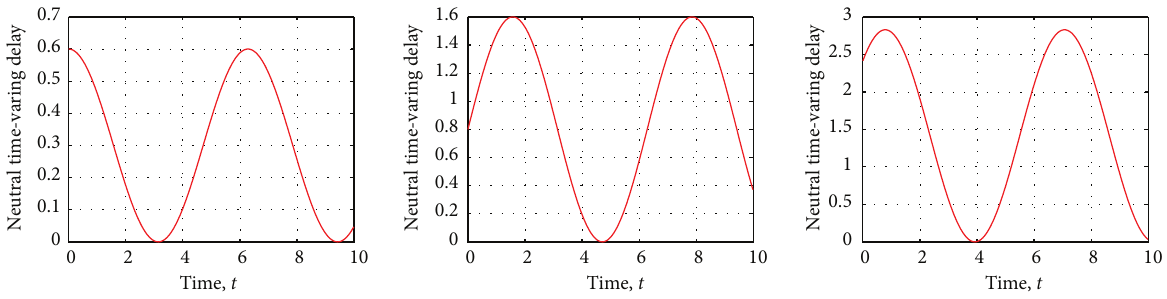
Figure 1: Neutral time-varying delay 𝜏 𝑖 (𝑡) at Mode 1, Mode 2, and Mode